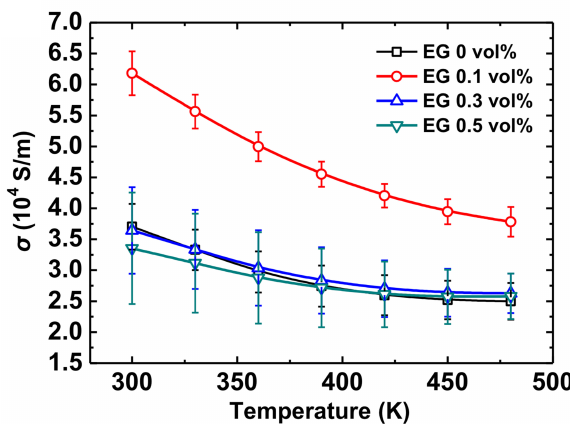
Figure 15: Temperature dependence of electrical conductivity of Bi 0.5 Sb 1.5 Te 3 – Expanded graphene (EG). Reproduced from Ref.